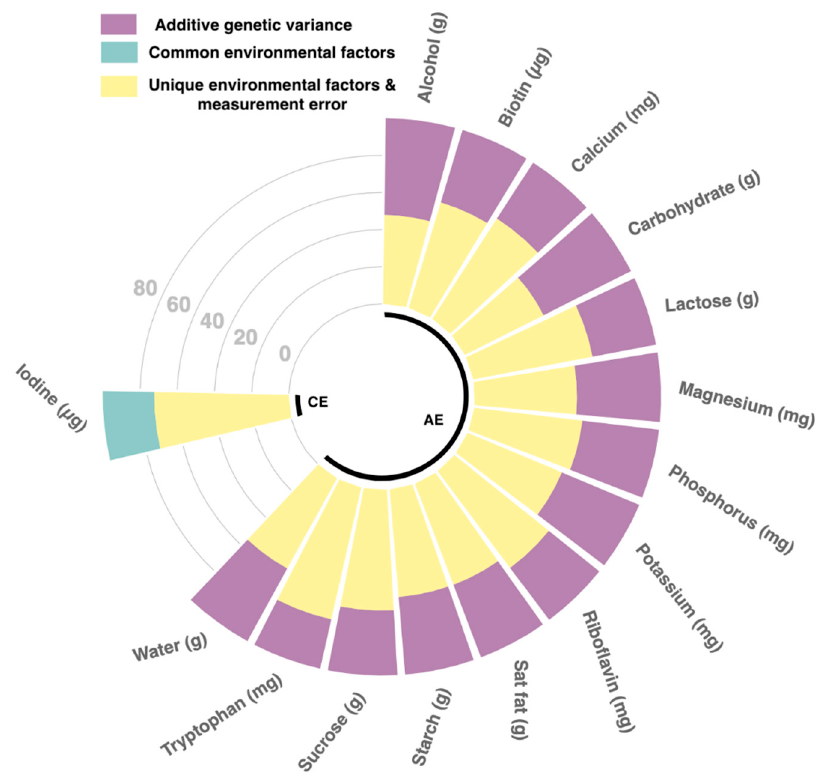
Figure 2. Circus plot of heritability for significantly associated nutrients. Plot of heritability analysis depicting sources of phenotypic variation for the 15 nutrients significantly associated with blood pressure. Nutrients in group AE were genetically derived, whereas nutrients in group CE were environmentally determined (model lowest AIC). Purple bars represent additive genetic variance, teal represent common environmental factors and yellow specific environmental factors & error.